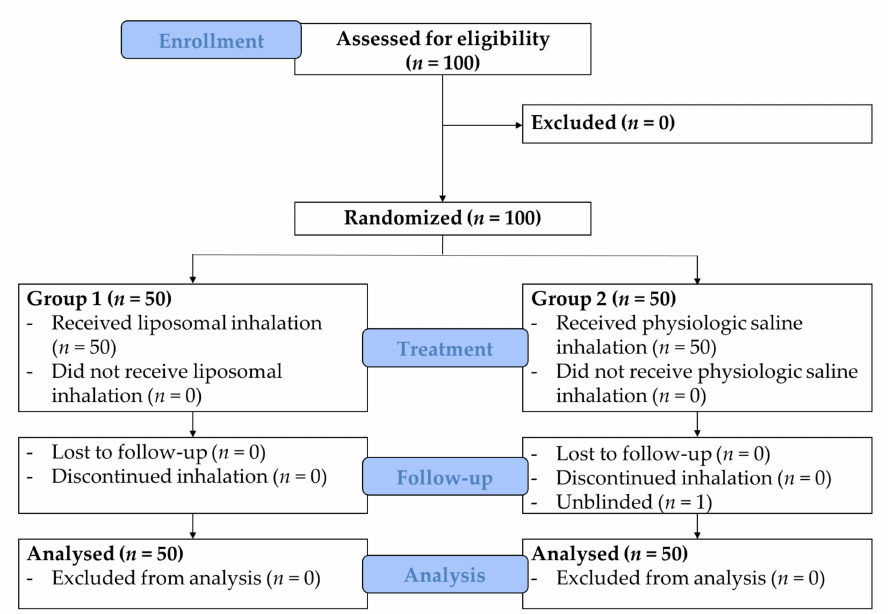
Figure 2. CONSORT flow